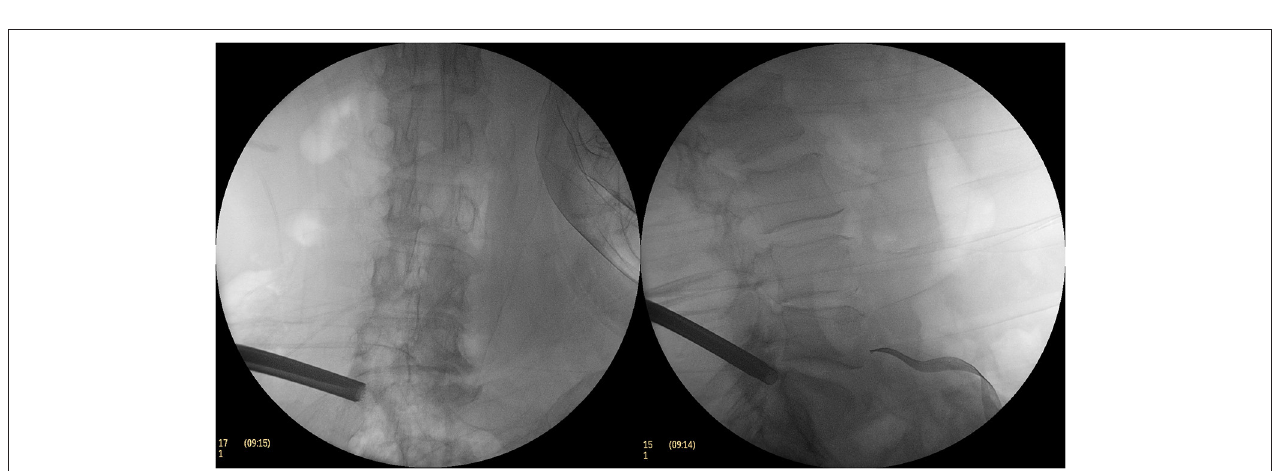
FIGURE 3 | The C-arm fluoroscopic picture of the excised part of the superior articular process with a circular saw.